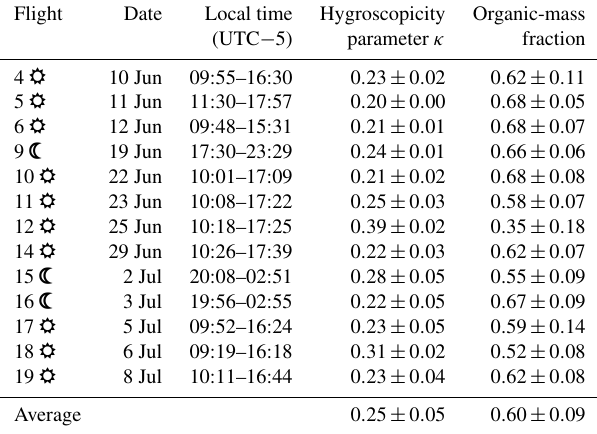
Table 1. Research flights from the SENEX 2013 campaign used in this study. The symbol “ ” next to each flight number refers to a daytime flight, and “ ” refers to a nighttime